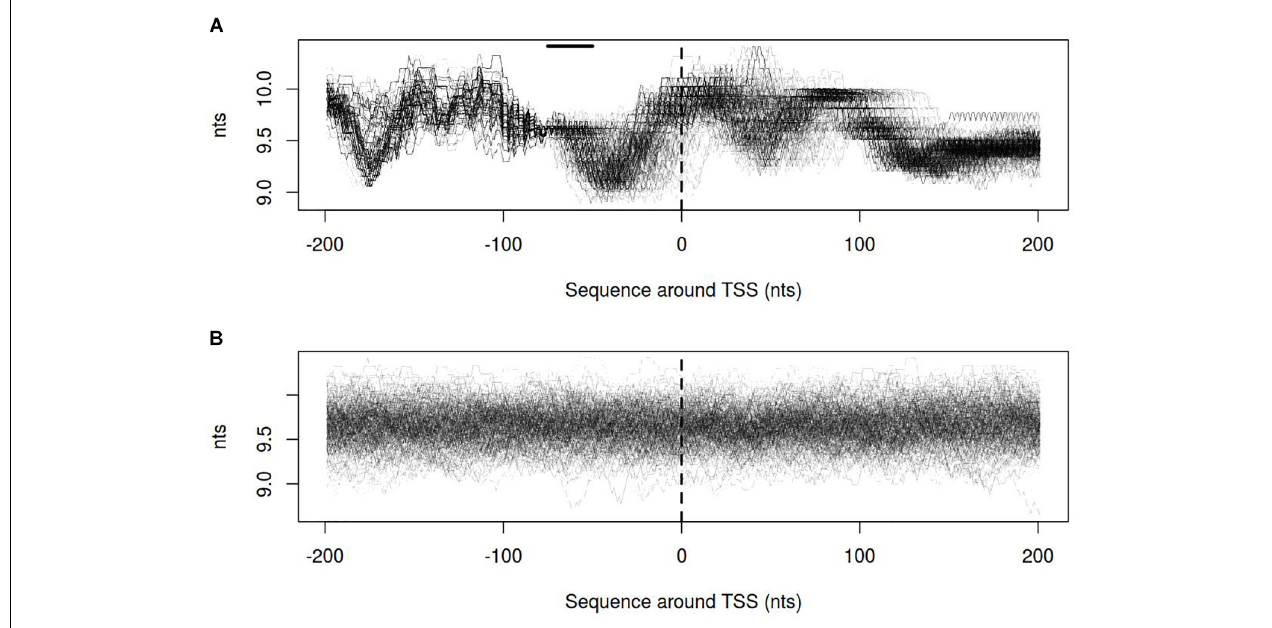
FIGURE 8 | Size of open states profiles for (A) vlhA promoters of 12 M. gallisepticum strains; (B) sigma 70 promoters of S6 strain. Dashed line denotes transcription start site; solid horizontal line – approximate GAA repeats location.